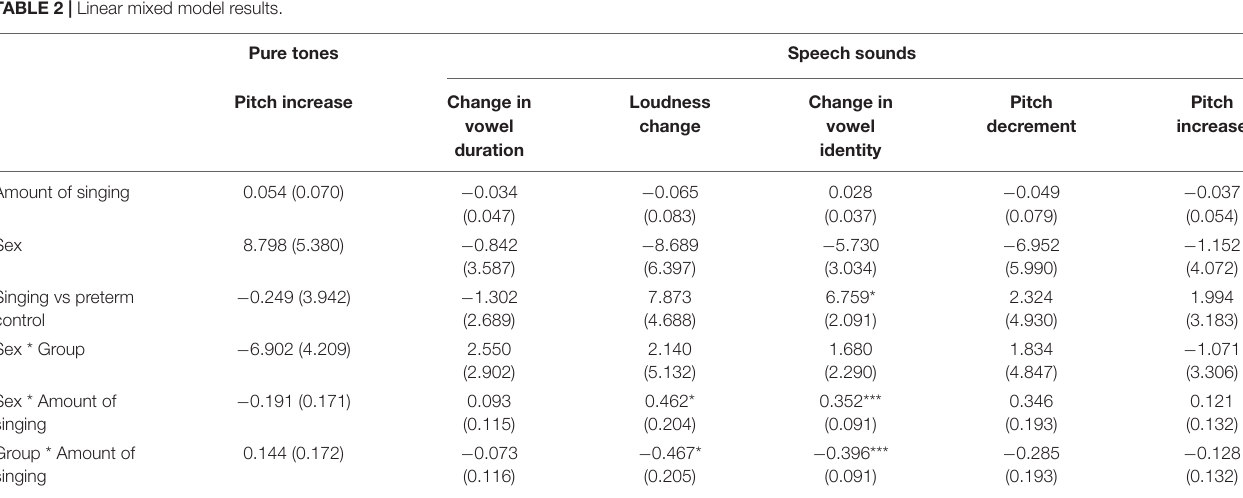
TABLE 2 | Linear mixed model